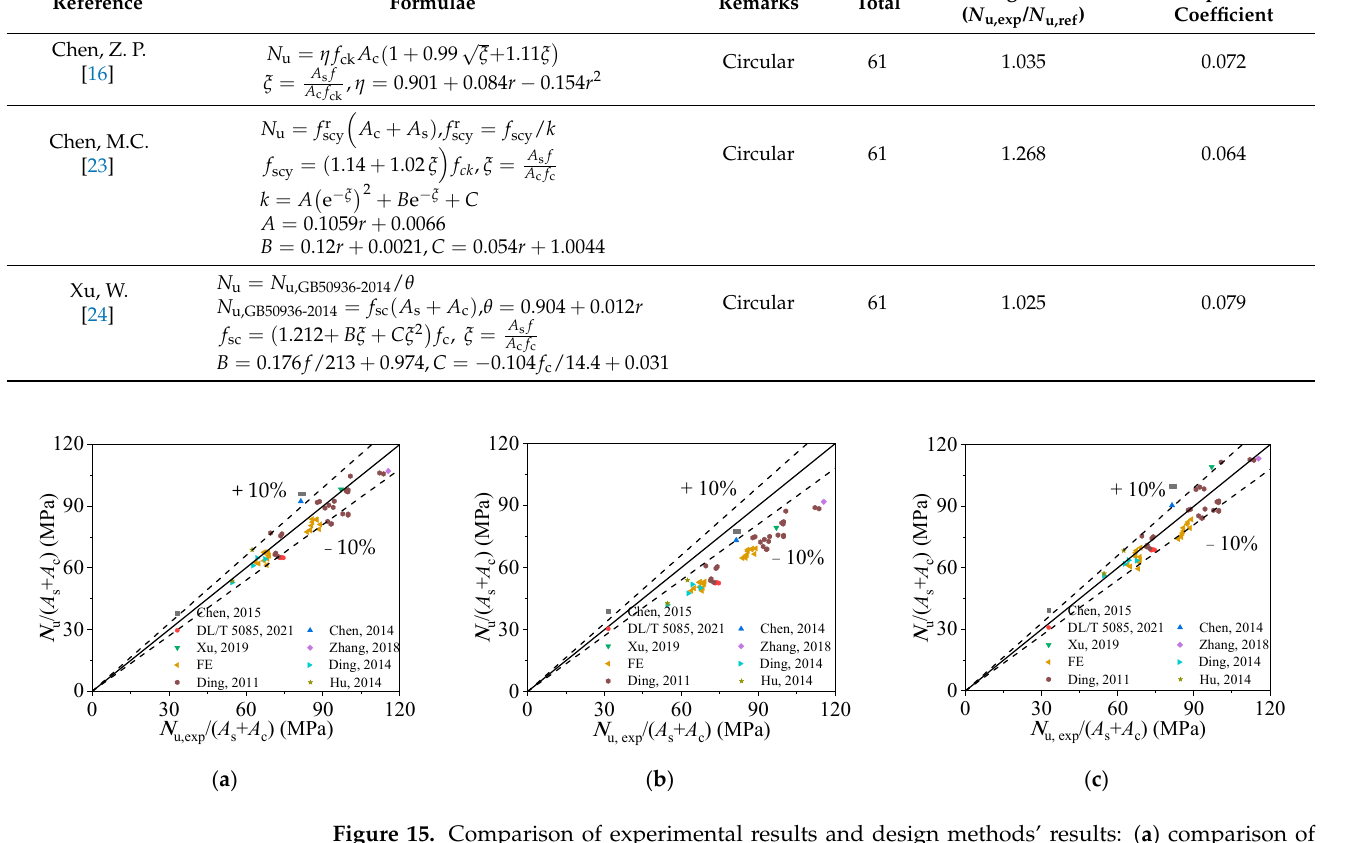
Figure 15. Comparison of experimental results and design methods’ results: ( a ) comparison of ultimate bearing stress obtained from test results and Reference [16]; ( b ) comparison of ultimate bearing stress obtained from test results and Reference [23]; ( c ) comparison of ultimate bearing stress obtained from test results and Reference [24].